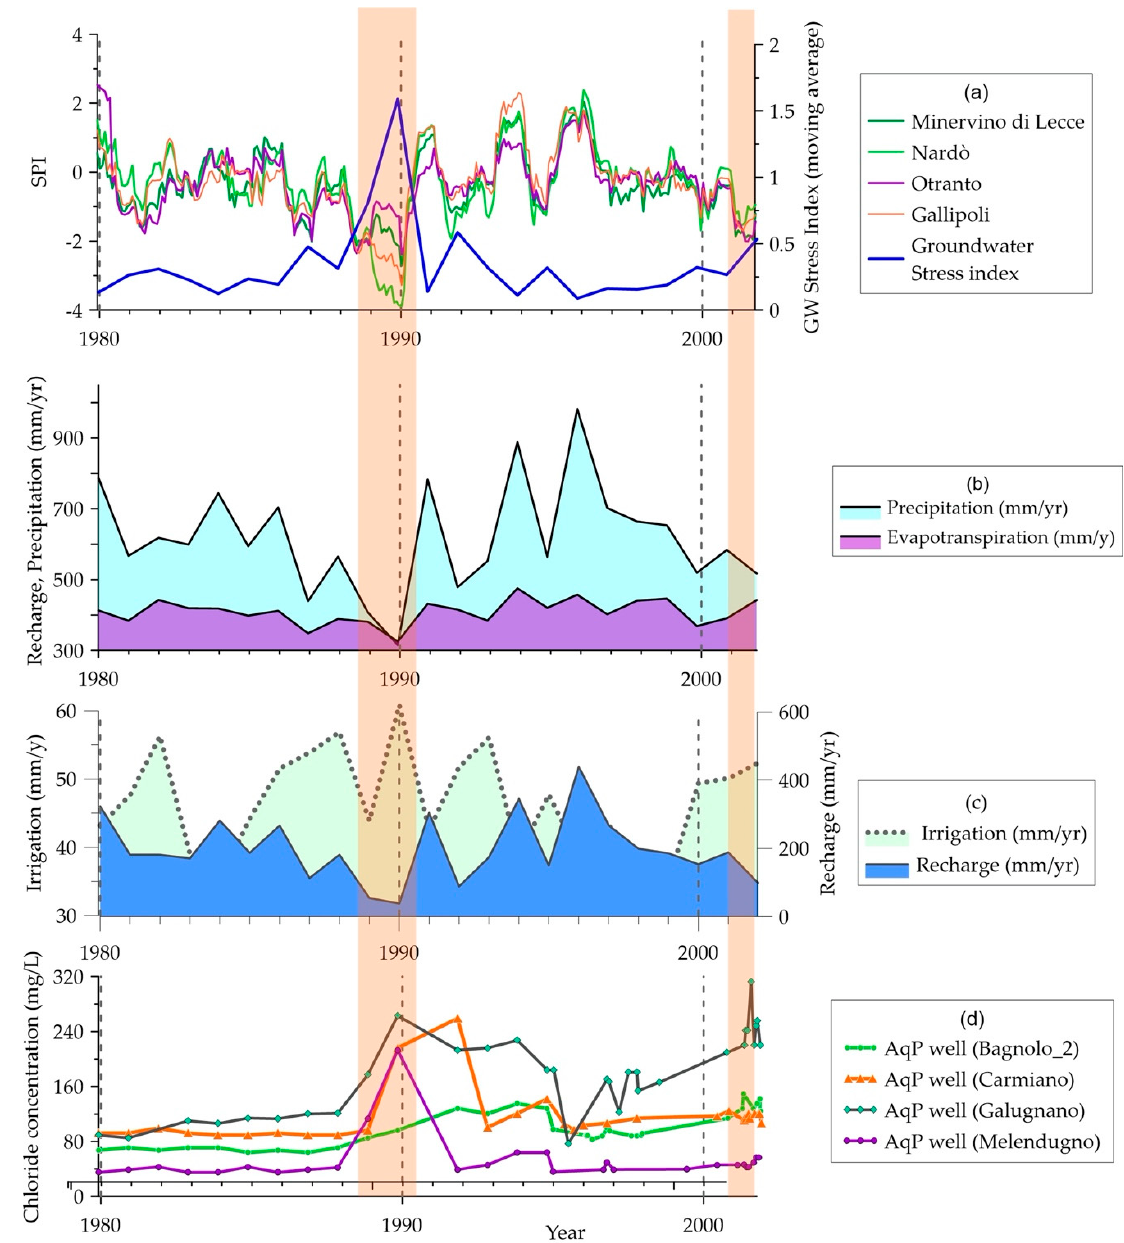
Figure 6. SPI ( a ) calculated for precipitation measured between 1980–2002 at the Nardò, Otranto, Minervino di Lecce and Gallipoli rain gauge stations compared to ( a ) GWS, ( b ) yearly precipitation, evapotranspiration and ( c ) irrigation and recharge. GWS and data shown in ( b ) and ( c ) refer to the entire Salento aquifer. ( d ) Chloride concentrations measured in samples from AqP wells tapping